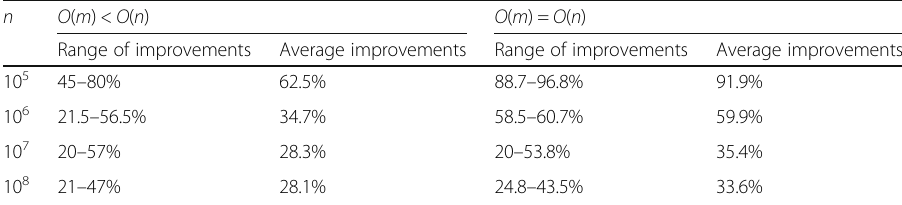
Table 1 Range of improvements for the CS and DHS algorithms n O ( m ) < O ( n ) O ( m ) = O ( n ) Range of improvements Average improvements Range of improvements Average improvements 10 5 45 – 80%